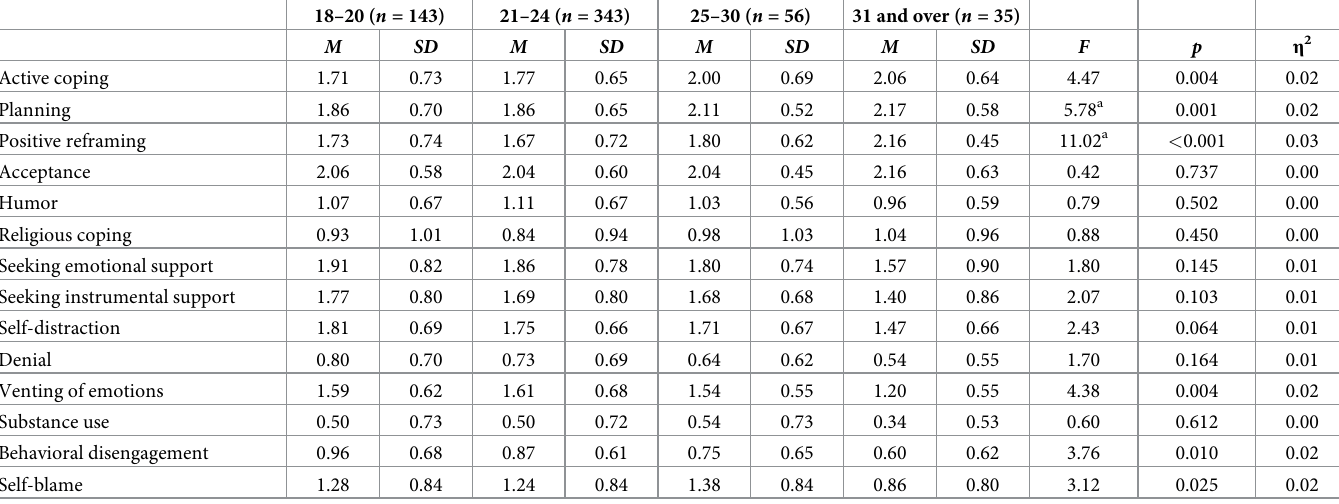
Table 7. One-way analysis of variance of differences in strategies of coping with stress between age